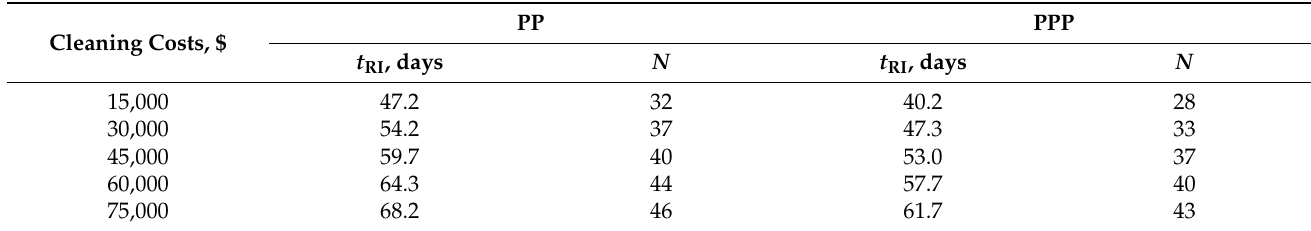
Table 6. The time needed to achieve the return on the